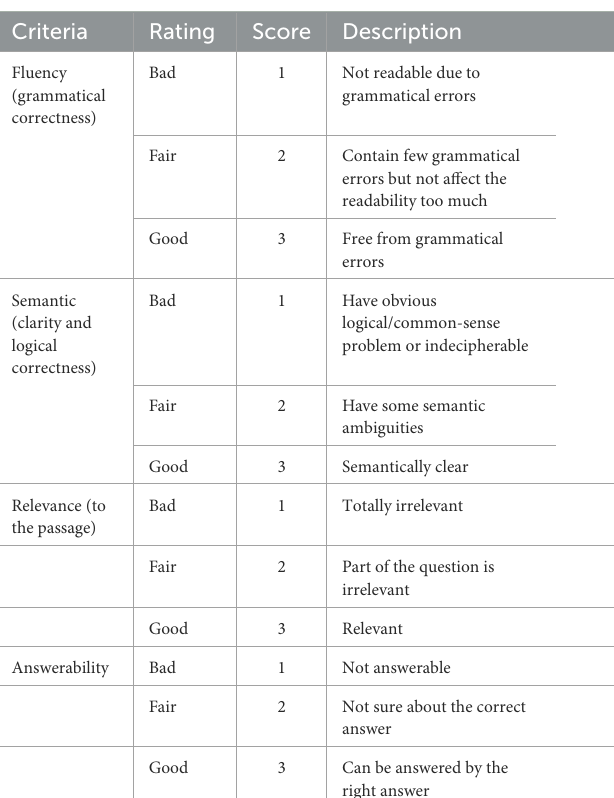
TABLE 4 Human evaluation metrics with description (Zou et al.,